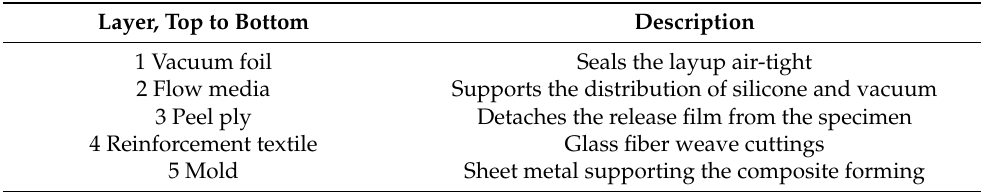
Table 1. Composite layup for the production of fiber-rubber